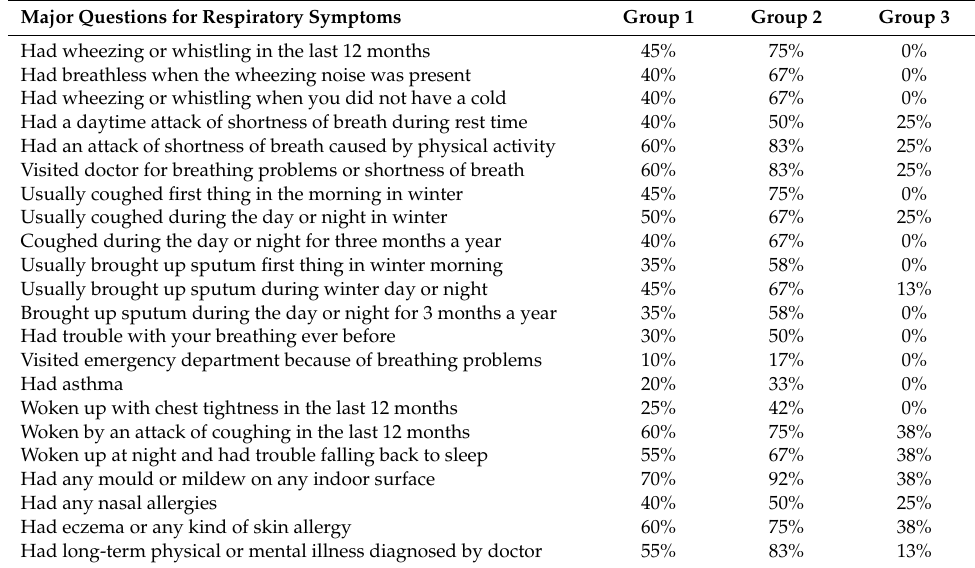
Table 7. Partial Respiratory Health Survey results of the three groups of